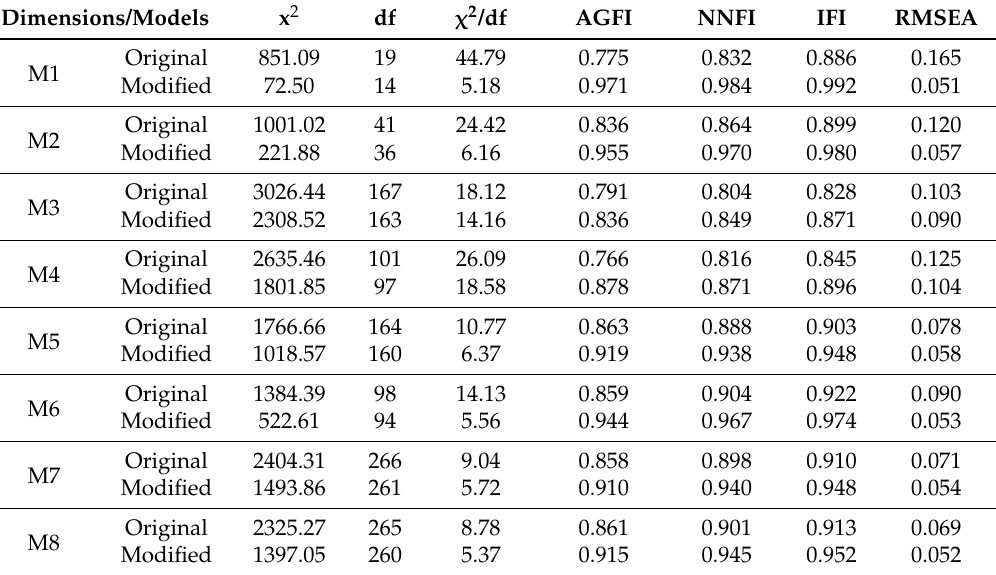
Table 2. The process of model fitting and the goodness of fit of structural